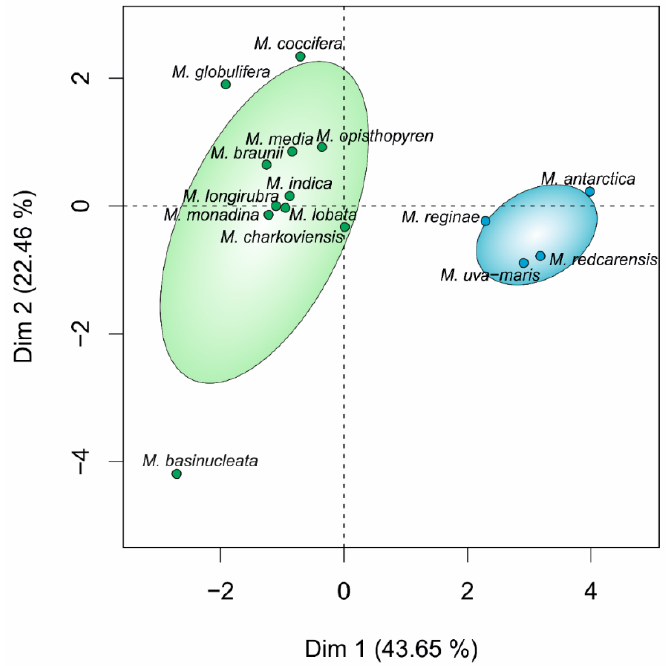
Figure 6. Principal component map showing morphological and ecological dissimilarities between marine (blue) and freshwater (green) Microglena species.